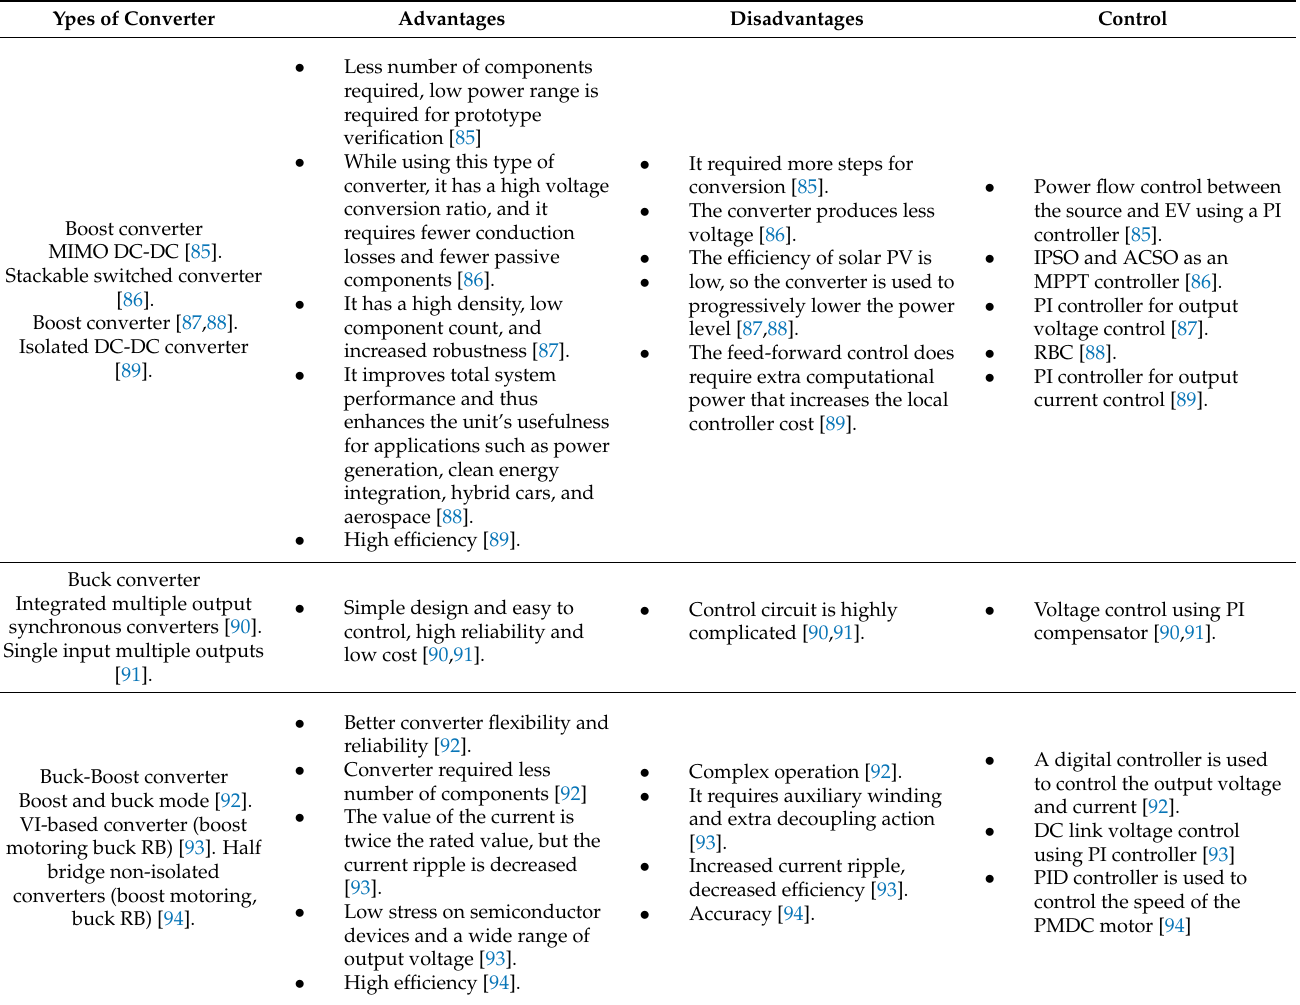
Table 10. Performance comparison of converters. Ypes of